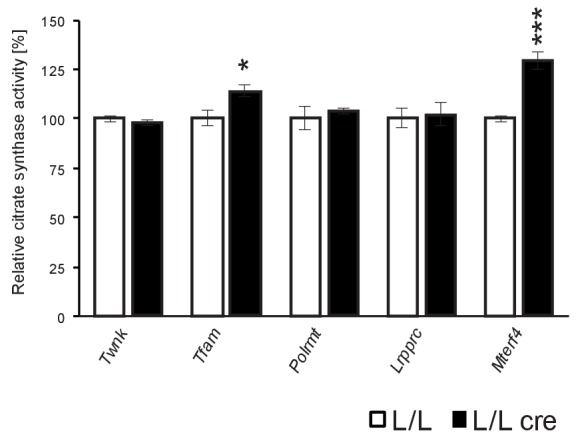
Activity of citrate synthase in heart from different L/L, cre and L/L mice.Error bars ± SEM; *p<0.05, ***p<0.001; two-tailed unpaired Student’s t-test.10.7554/eLife.30952.007Figure 1—figure supplement 1—source data 1.Determination of citrate synthase activity.